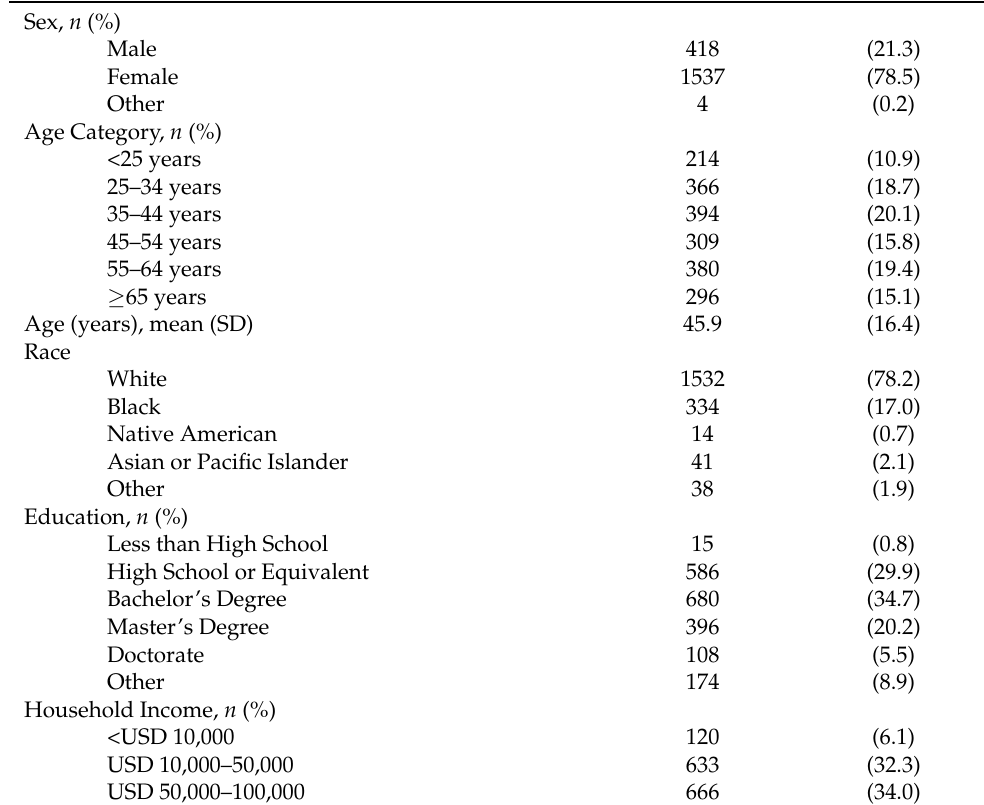
Table 1. Characteristics of participants who completed the Food Intake Assessment Preference Survey (N =